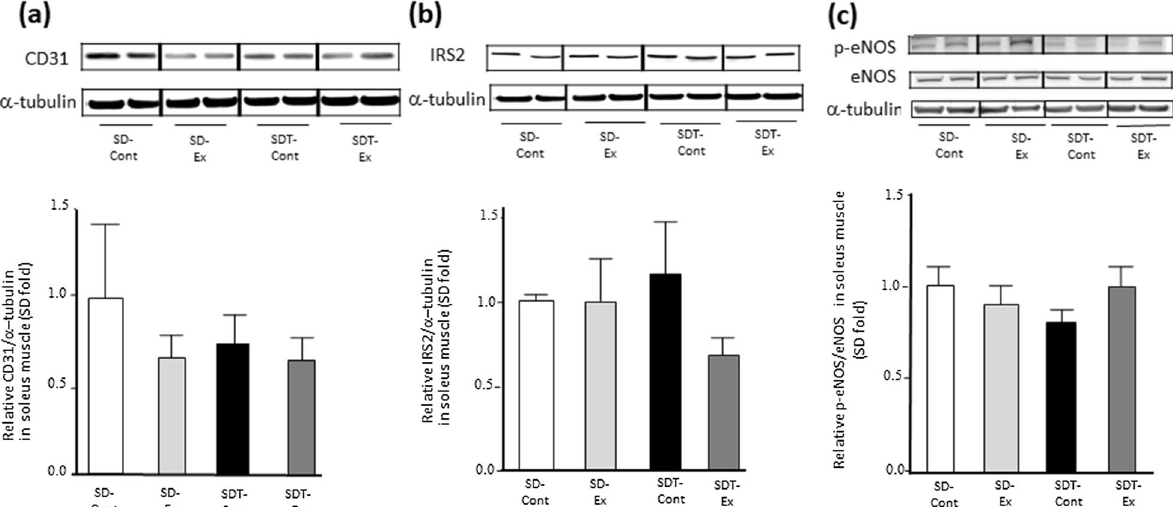
Fig. 8 Protein expression related to vascular endothelial cells in the soleus muscle. Protein expression of CD31 ( a ), insulin receptor substrate 2 (IRS2) ( b ), and phosphorylated endothelial nitric oxide synthase (eNOS) (c) as determined by western blot analysis. Entire images of western blotting are shown in online Additional file 1: Figure S9 (b, d, f) and S10 (b, d, f). Values are presented as mean